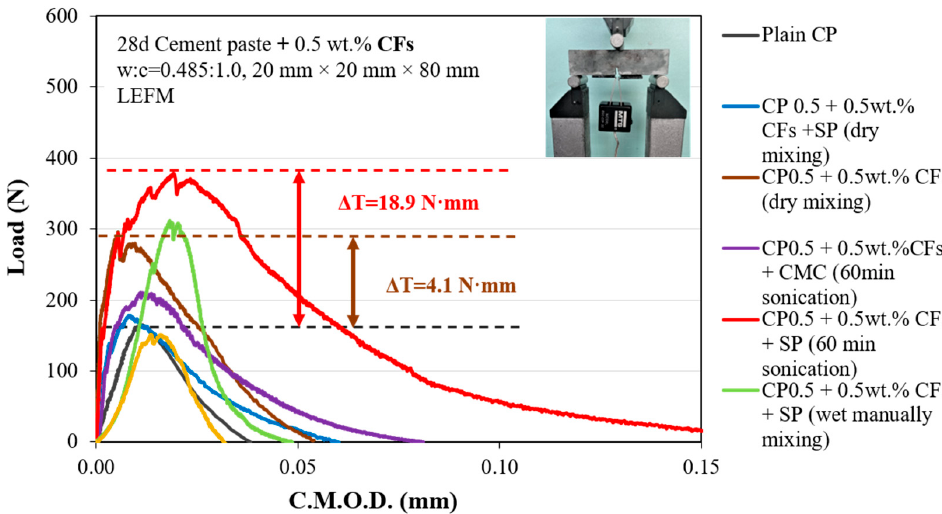
Figure 19. Load–CMOD curves of 28-day plain and CFs composite cement pastes at volume fractions of 0.5% from LEFM tests of 20 mm × 20 mm × 80 mm specimens.